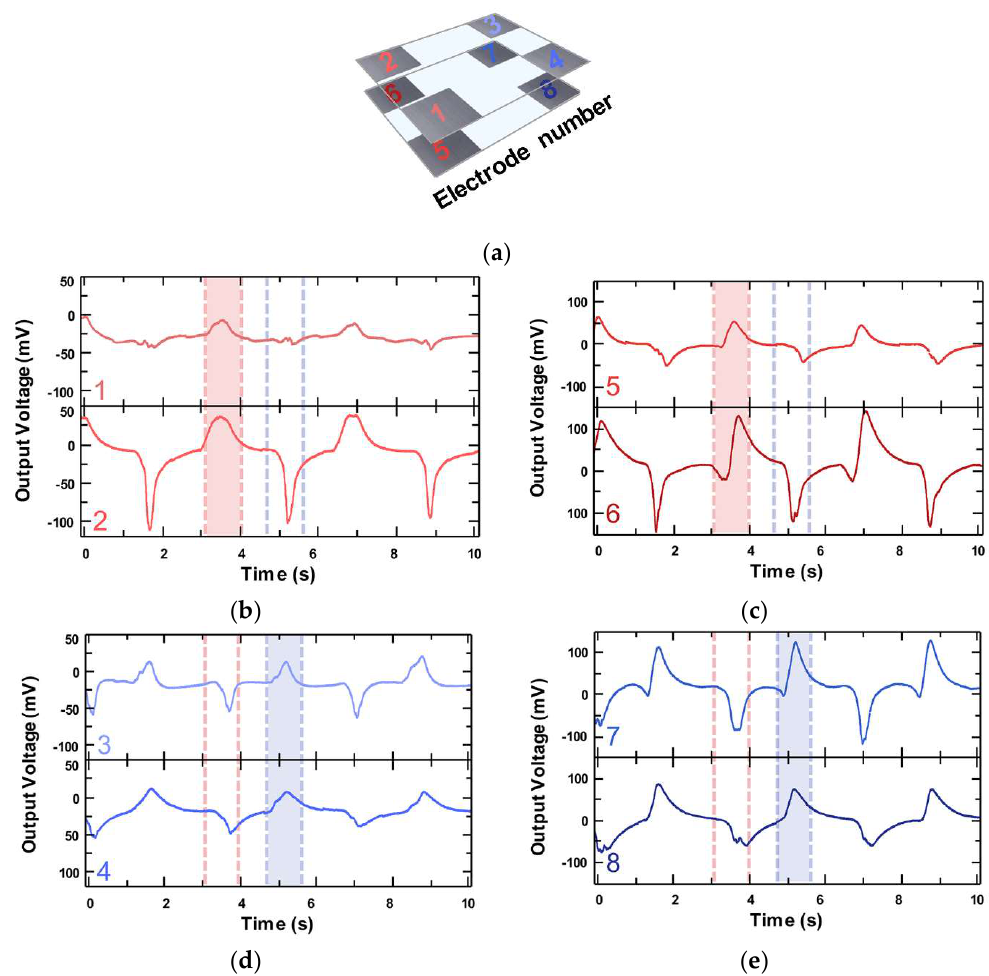
Figure 5. ( a ) The schematic of the OT-TES and each electrode number. ( b–e ) Voltage measurements of the OT-TES from eight Al electrodes when the tilt is 45 degrees to the left and right side and around to the center of the OT-TES: ( b ) The DAQ output voltage of electrode 1 and 2, and ( c ) the DAQ output voltage of electrode 5 and 6. ( d ) The DAQ output voltage of electrode 3 and 4, and ( e ) the DAQ output voltage of electrode 7 and 8.